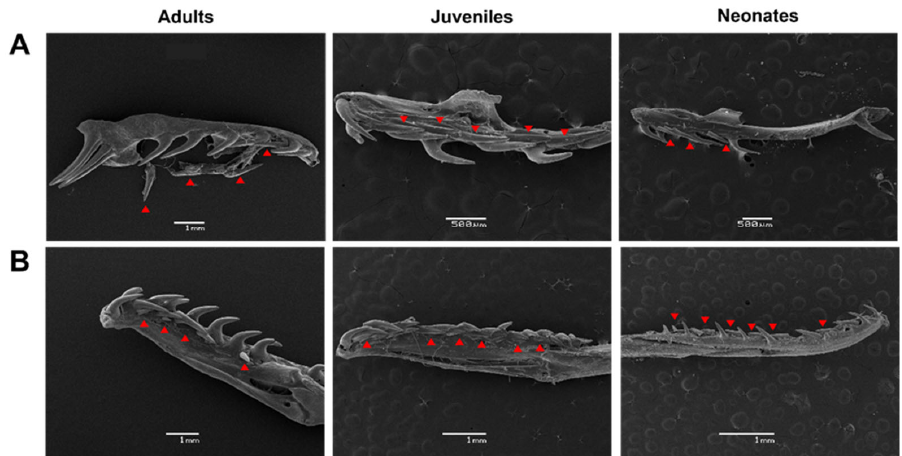
Figure 6. Presence of replacement tooth in maxilla and dentary bones. Red arrows indicate linear replacement teeth from ( A ) maxilla and ( B ) dentary bones. For ( A ), MZUC 45,037 (labial view), 45,000 (lingual view), and 45,036 (lingual view) were used; and for ( B ), MZUC 45,037 (lingual view), 44,998 (lingual view), and 45,032 (labial view) were used. Biology 2022 , 11 , x FOR PEER REVIEW